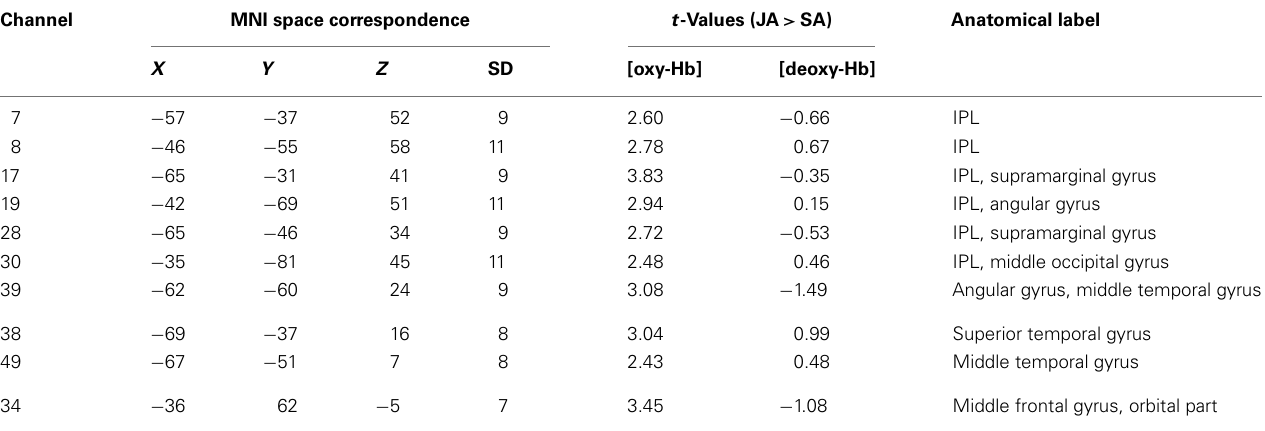
Table 1 | Channel t -values and anatomical labels for the contrast (JA > SA).